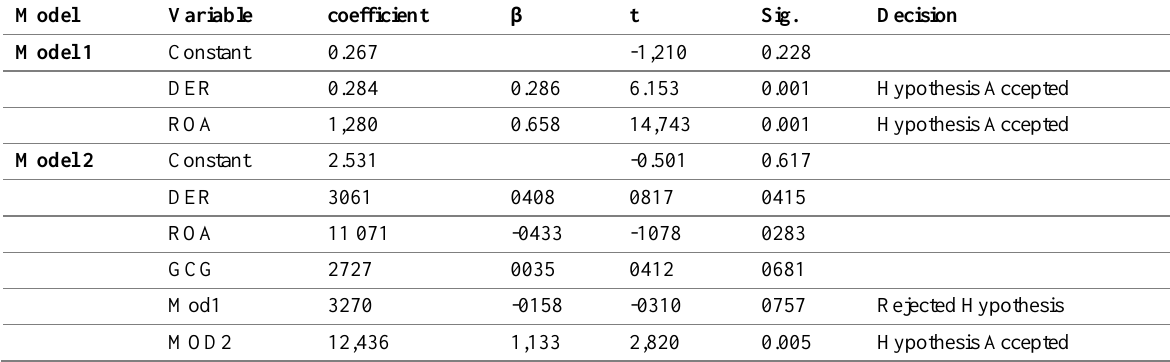
Table 3: Test Result